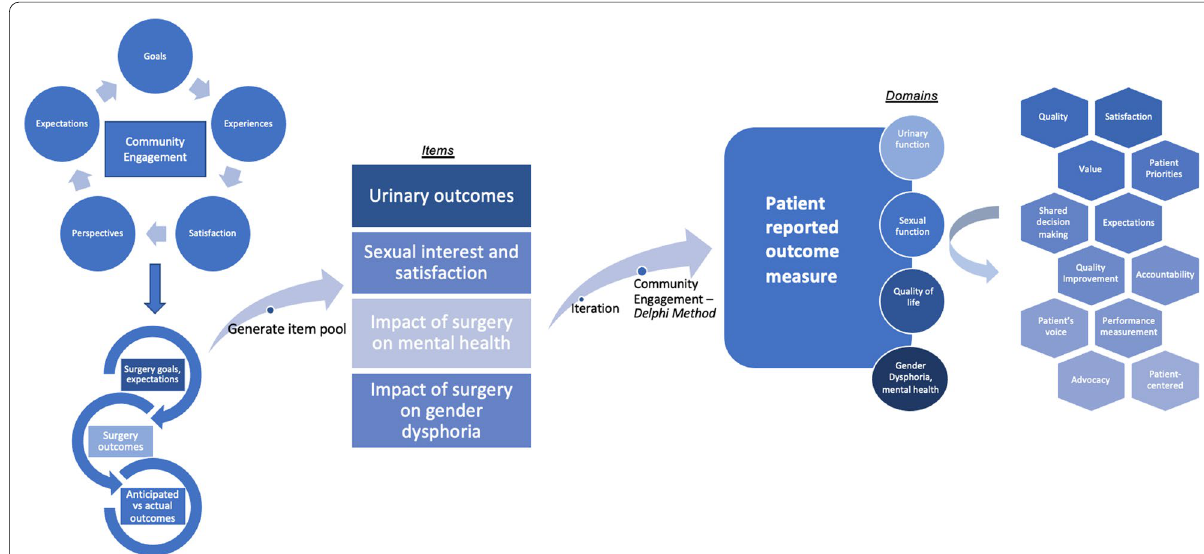
Fig. 2 Potential themes, items, and domains resulting from community‑based participatory research model of PROM tool development in genital gender‑affirming